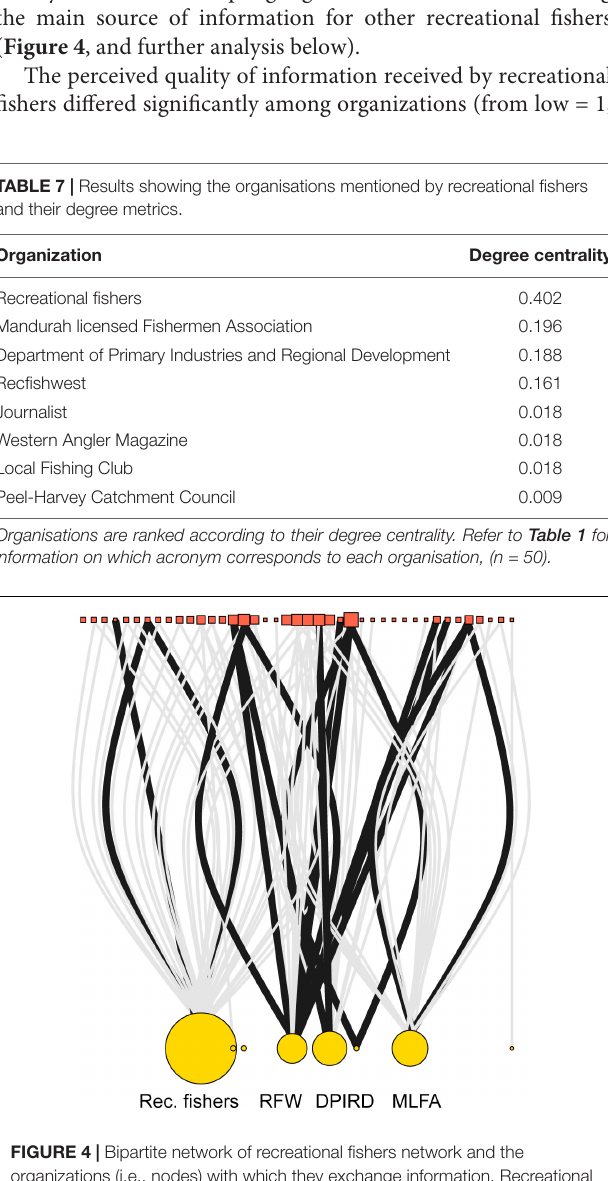
Frontiers in Marine Science |